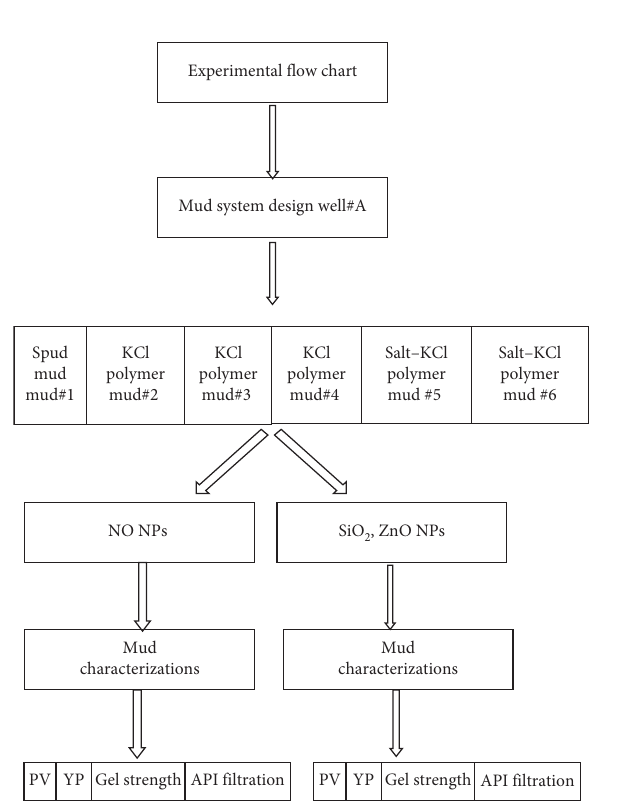
Figure 1: Experimental